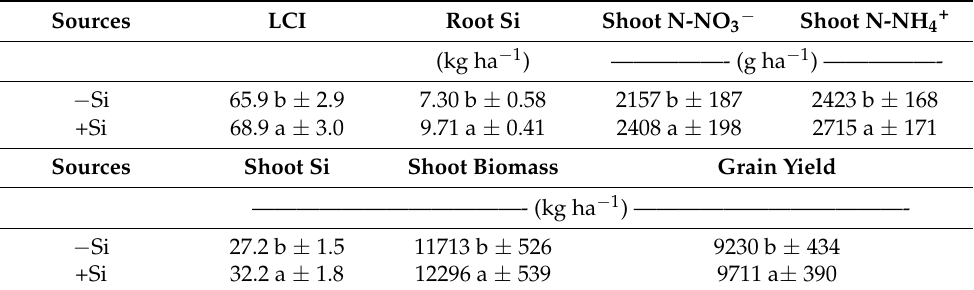
Table 1. Maize leaf chlorophyll index (LCI); root Si accumulation; shoot nitrate (N-NO 3 − ); shoot ammonium (N-NH 4+ ); shoot Si accumulation; shoot biomass and grain yield as a function of Si amendment application.